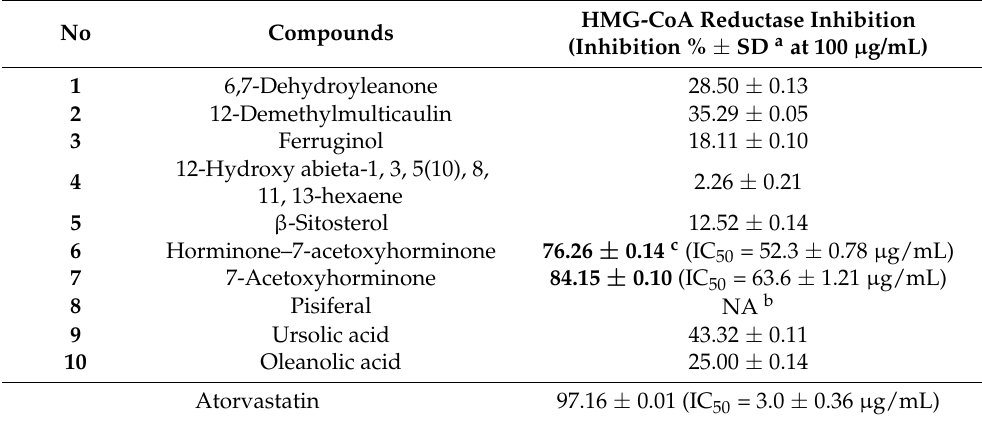
Table 2. HMG-CoA reductase inhibitory activity of the isolated compounds.